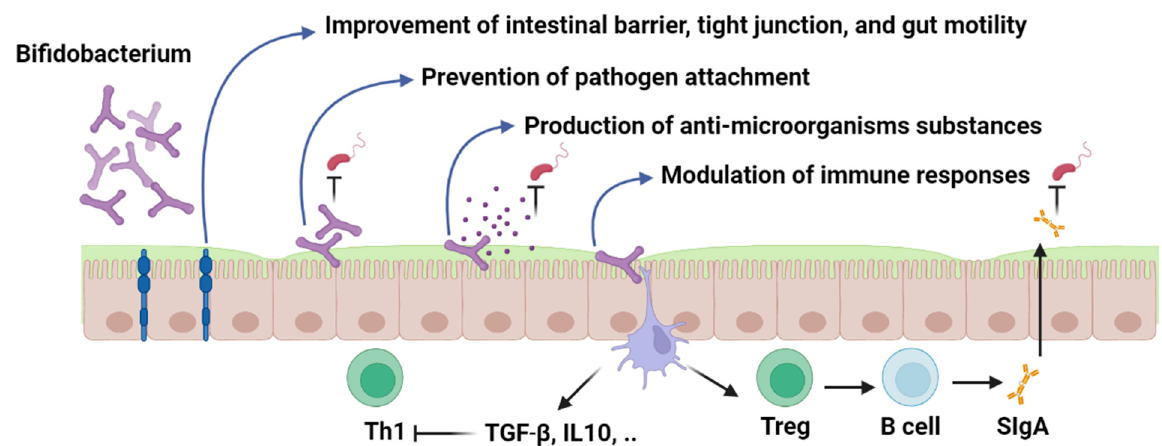
Figure 3. Bifidobacterium ; mechanism of action. Figures in this manuscript were created specifically for this manuscript in BioRender.com, accessed on 15 August